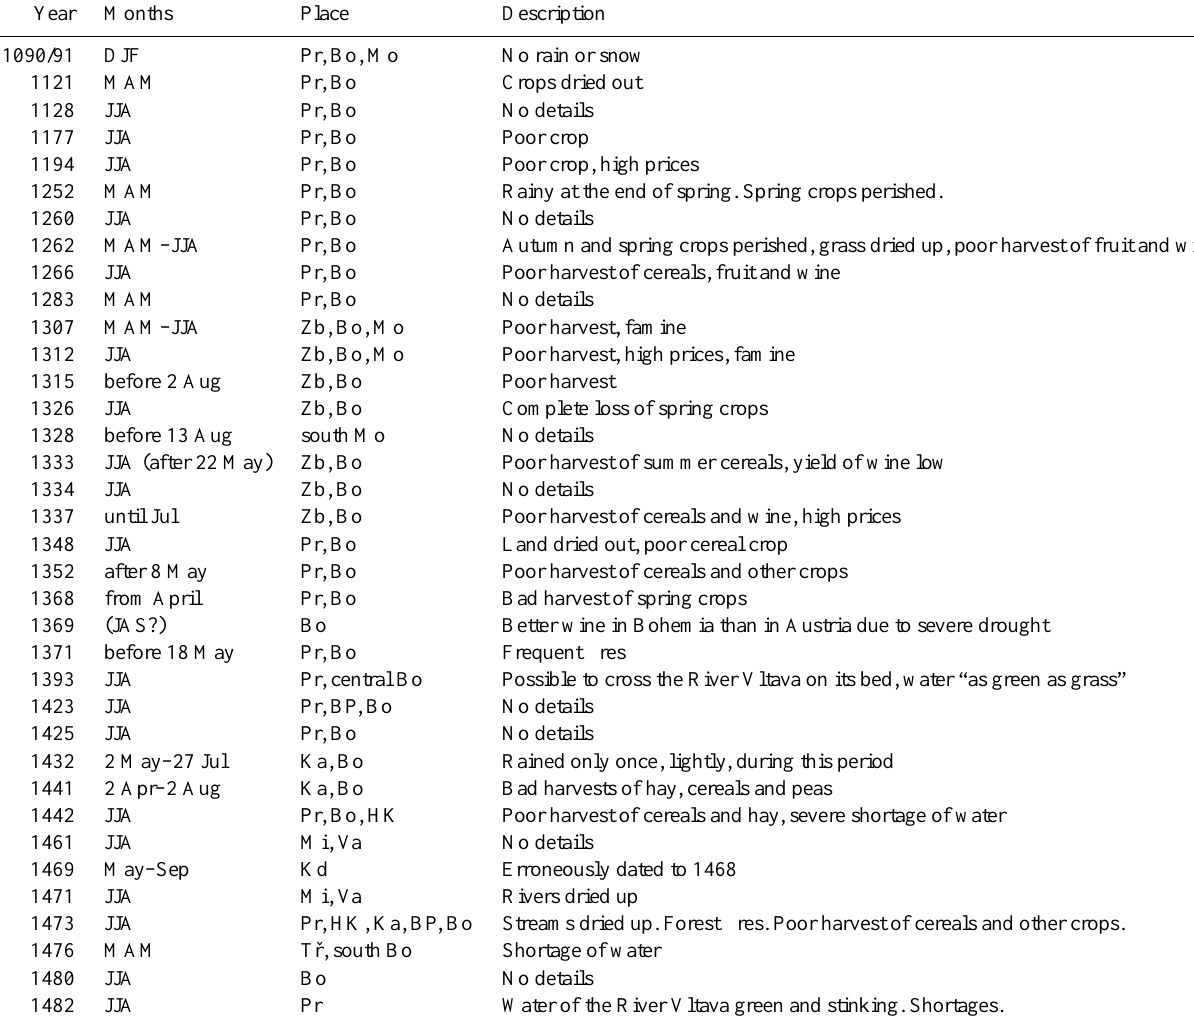
Table 1. Dry weather and droughts in the Czech Lands before 1500AD (Br´azdil and Kotyza, 1995): Bo – Bohemia, BP – Beneˇsov nad Plouˇcnic´ı, HK – Hradec Kr´alov´e, Ka – Karlˇstejn, Kd – Kadaˇn, Mi – Mimoˇn, Mo – Moravia, Pr – Prague, Tˇr – Tˇreboˇn, Va – Varnsdorf, Zb –